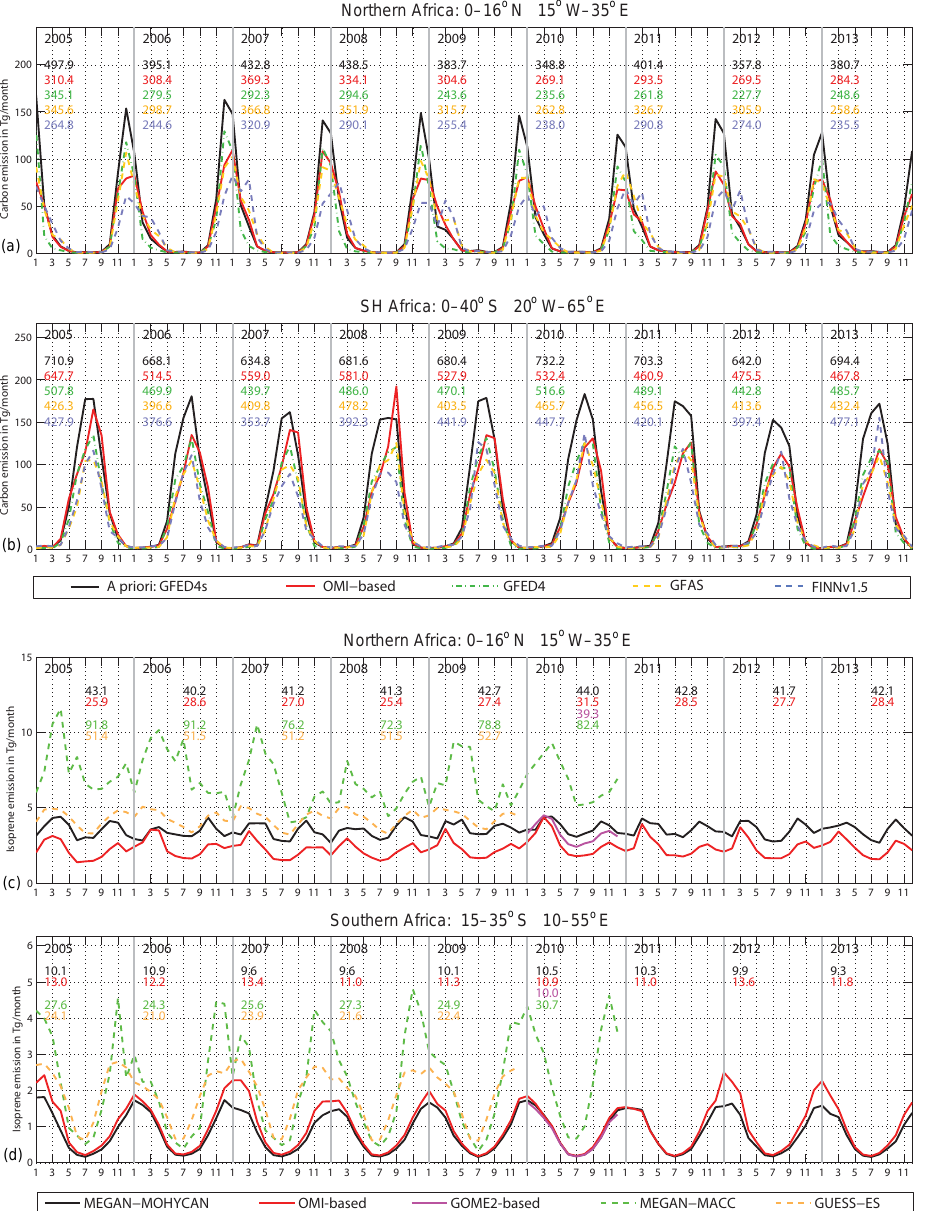
Figure 11. As Fig. 9 but for Africa.